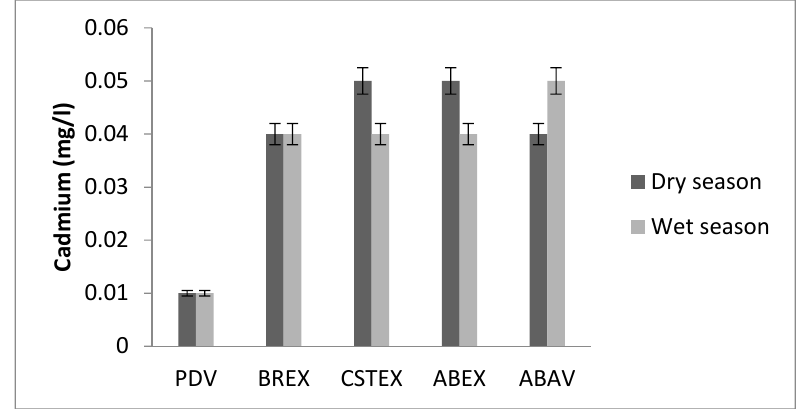
Figure 8. Cadmium Figure 8. Cadmium concentration. Figure 8. Cadmium concentration.